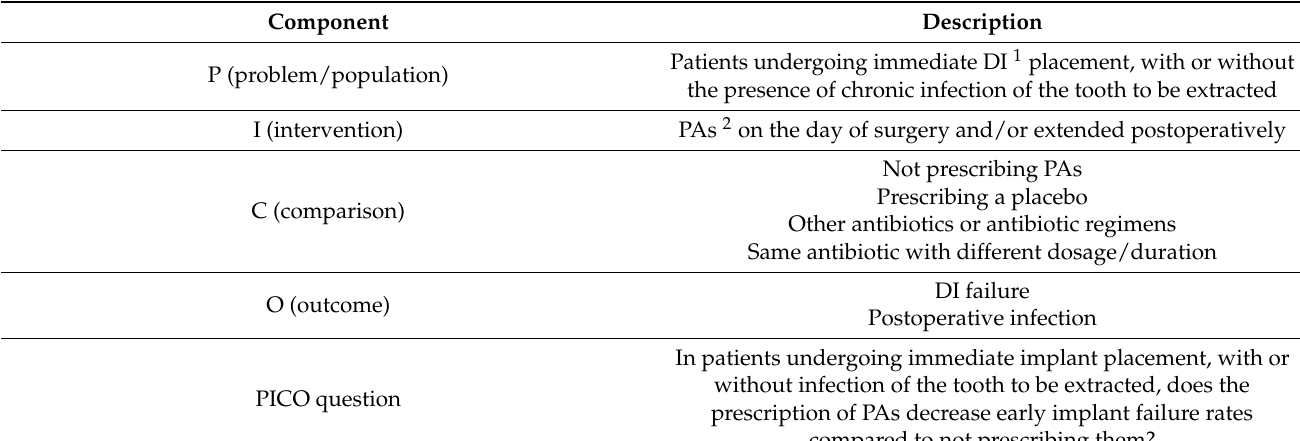
Table 1. Breakdown of the “PICO”